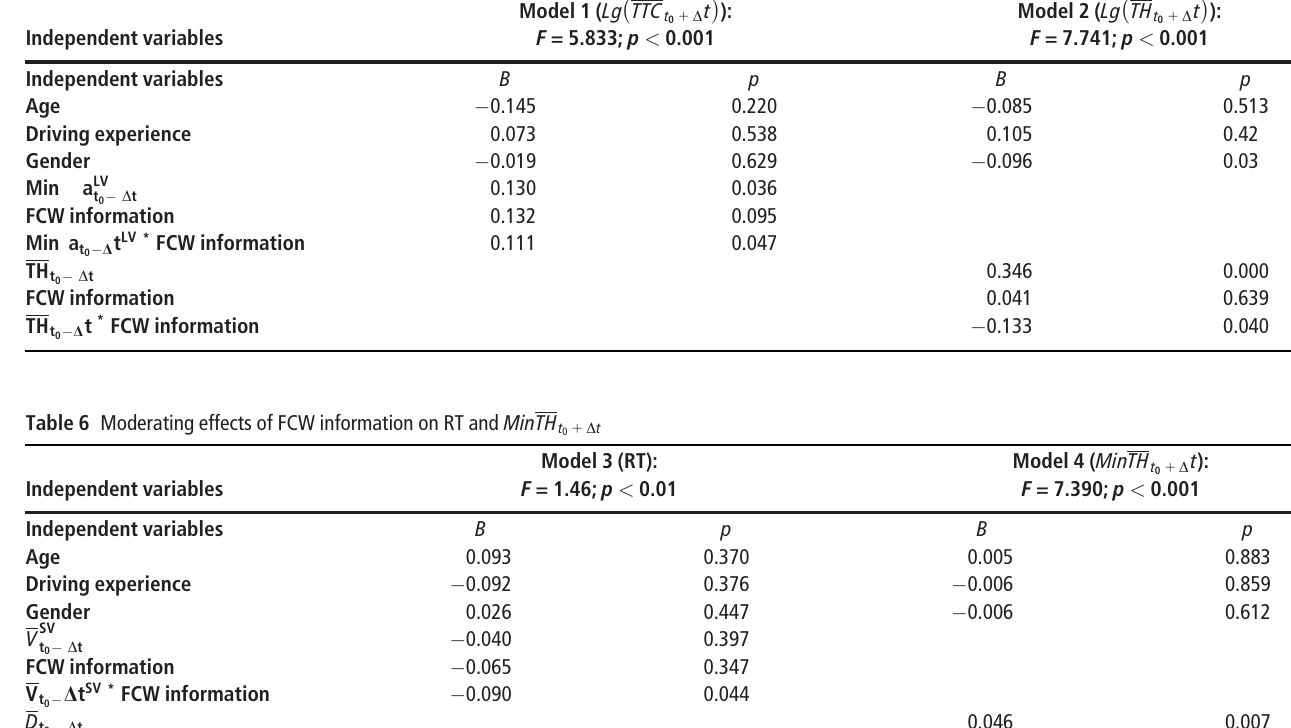
Table 5 Moderating effects of FCW information on Lg TTC t